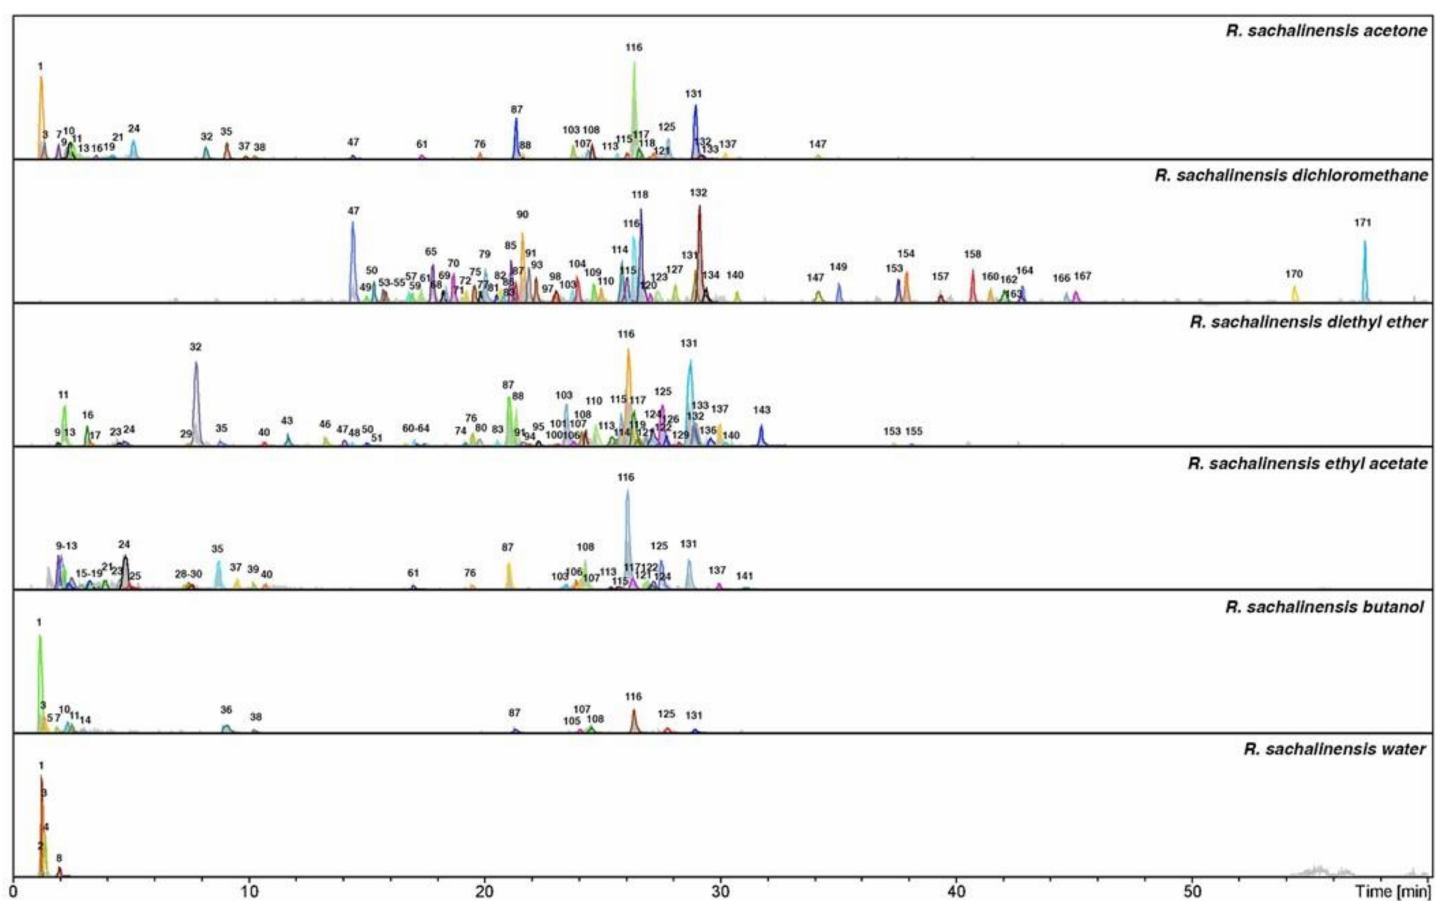
Figure 3. Total ion chromatograms in negative ionization mode and dissect chromatograms of Reynoutria sachalinensis extract and fractions. Deconvolution of an LC/MS mass chromatogram was carried out by using the Bruker’s Dissect algorithm. Peak numbers are explained in Table